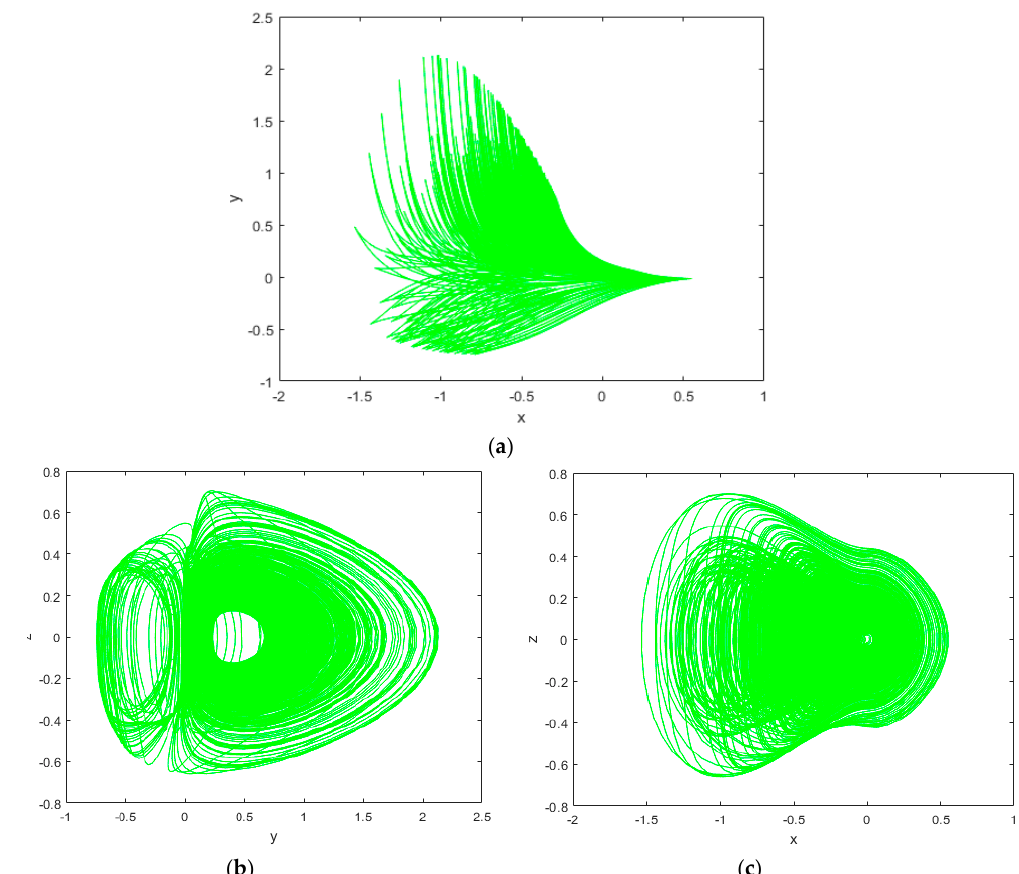
Electronics 2019 , 8 , x FOR PEER REVIEW Figure 2. MATLAB plots of the new chaotic System (2) ( a ) x - y plane, ( b ) y - z plane and ( c ) x - z plane. The bifurcation analysis of a nonlinear dynamical system is useful for knowing the behavior of the system both chaotic or periodic behavior for certain values of the system parameters [18–23]. Lyapunov exponent spectrum and bifurcation diagram are obtained for b = 4.5, c = 1 as a varies between 4 to 15 and initial condition X(0) = (0.01, 0.02, 0.01). Lyapunov exponent spectrum and